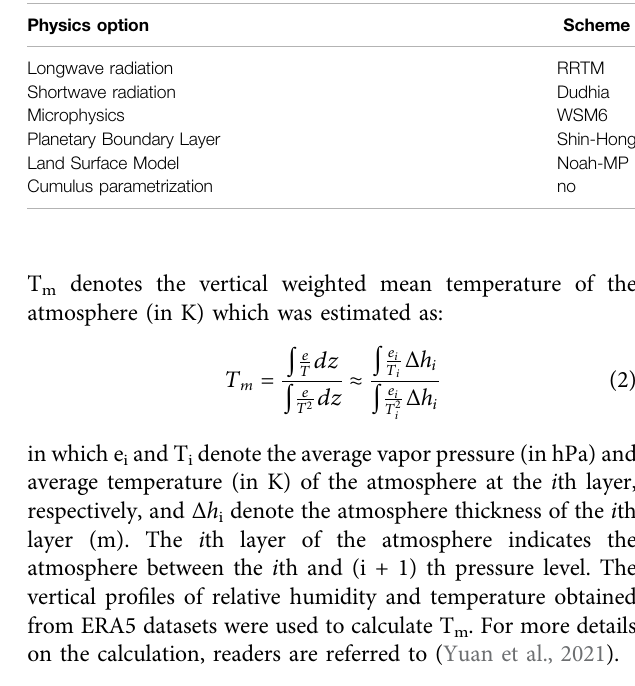
TABLE 1 | WRF Model settings: RRTM (Mlawer et al., 1997), Dudhia (1989), WSM6(HongandLim,2006),ShinandHong(2013),andNoah-MP(Niuetal.,